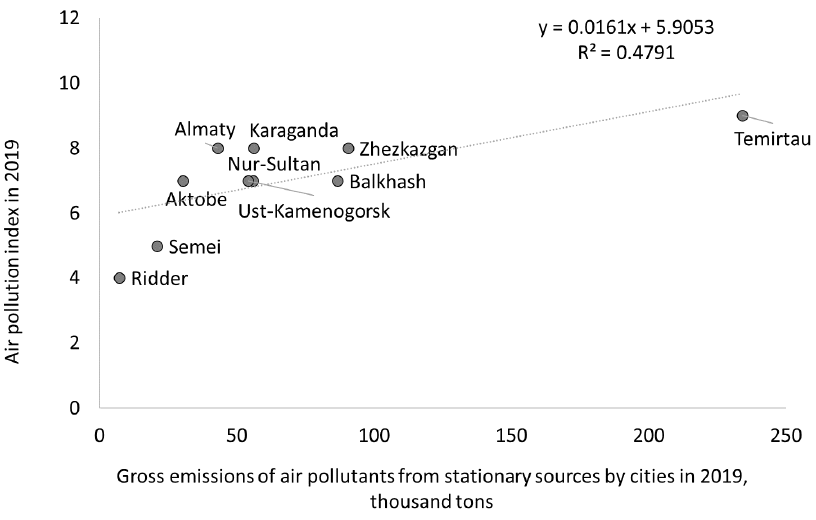
Figure 5. Air pollution index and gross emissions from stationary sources in 2019 for ten cities